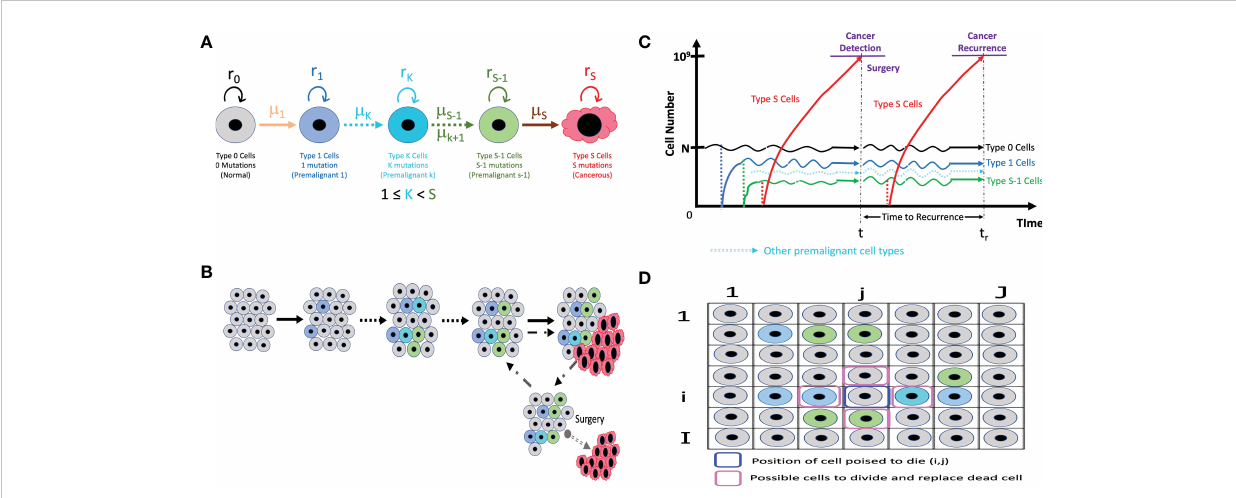
FIGURE 1 The illustrative representation of our models (A) The different cell types in our models with its own mutation rate ( µ ) and fi tness ( r ). Type K cells may not be applicable if only 3 mutations or less are needed for carcinogenesis. (B) In a normal tissue composed of Type 0, Type 1, Type K , and Type S -1 cells, cell turnover is conducted according to the Moran process, and the number of cells is kept constant. If a Type S cell emerges, it proliferates without limit and can be detected and primed for surgery when the cancer cell number reaches 10 9 . (C) At surgical intervention, all the Type S cells are resected while the number of Type 0, Type 1, Type K (if present) and Type S -1 cells remaining in a tissue are preserved. The time until the next Type S population reaches 10 9 is measured as time to recurrence. (D) The spatial structure integration in the model accounts for the positional relation between a cell poised to die and the possible cells that can divide to replace the dead